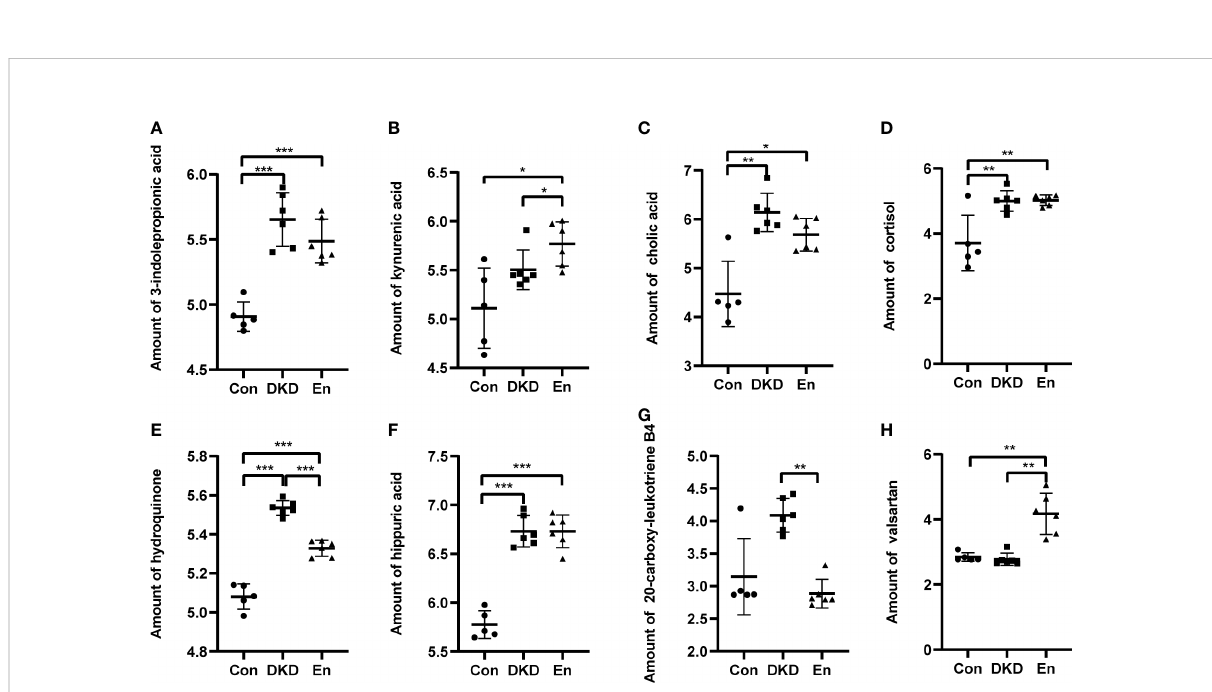
FIGURE 8 Relative amount of some differential metabolites. (A) 3-indolepropionic acid. (B) Kynurenic acid. (C) Cholic acid. (D) Cortisol. (E) Hydroquinone. (F) Hippuric acid. (G) 20-carboxy-leukotriene B4. (H) Valsartan. * p < 0.05, ** p < 0.01, *** p <